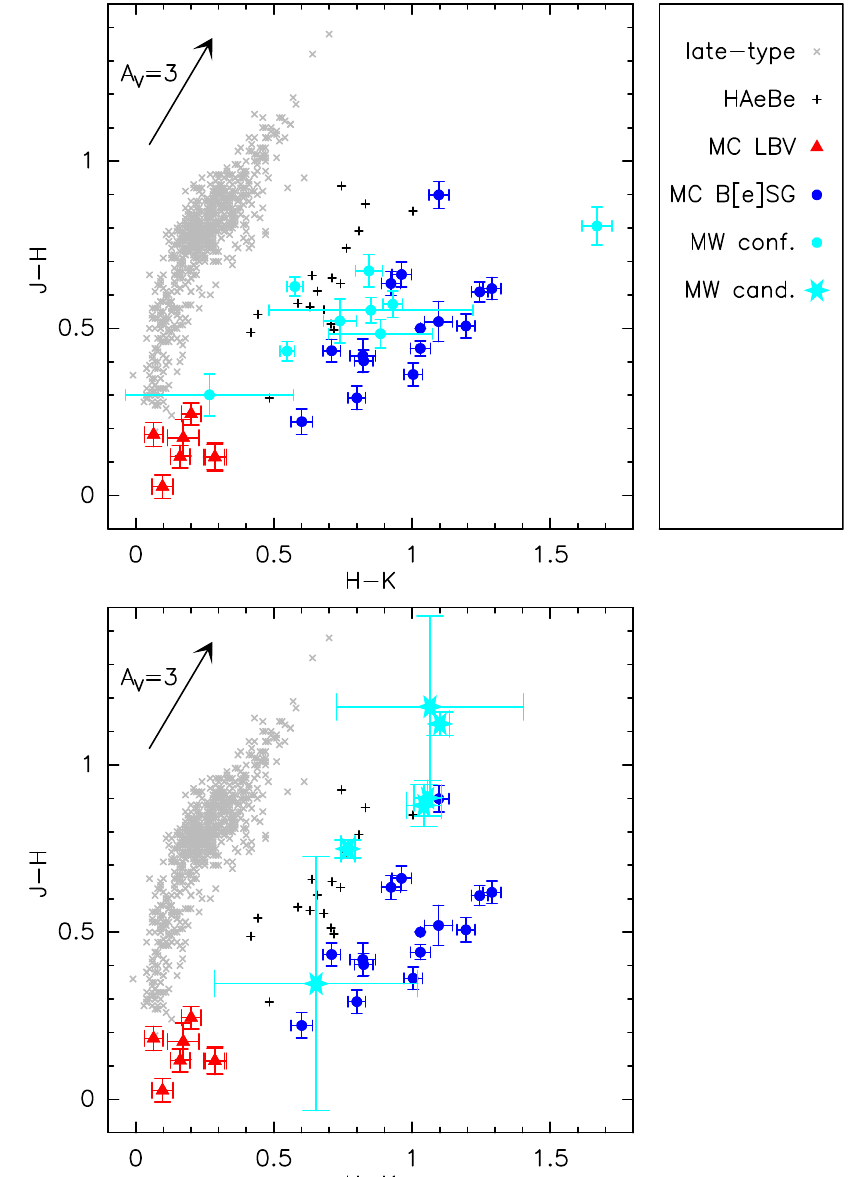
Figure 8. Near-IR diagrams as in Figure6, showing the locations of the Galactic confirmed B[e]SGs ( top ) and B[e]SG candidates ( bottom ). The colors of the Galactic objects have been corrected for interstellar extinction